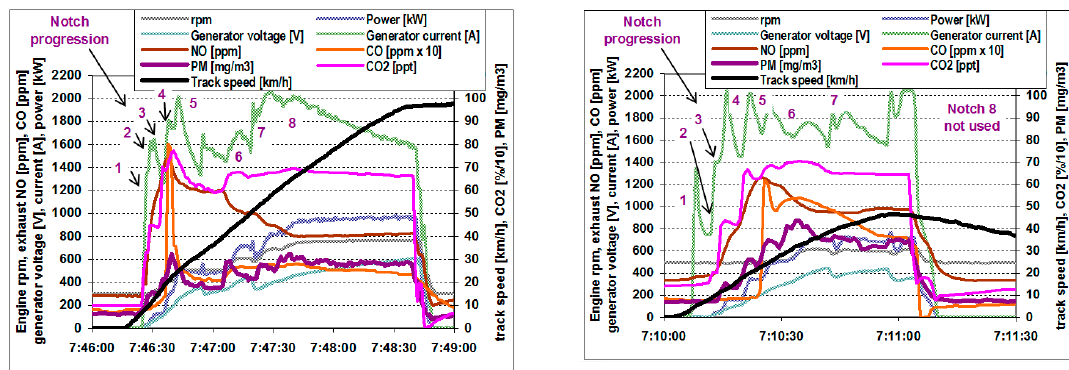
Figure 10. Generator voltage, current and power, running speed, and concentrations of NO x , CO, and PM during an acceleration of the five-car train from a station to high speed ( left ) and to a lower speed ( right ).